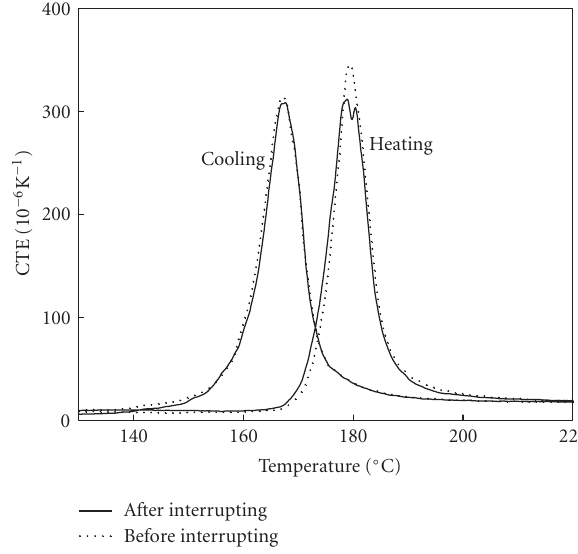
Figure 5: Temperature dependence of CTE for Ni 53 . 6 Mn 27 . 1 Ga 19 . 3 alloy after an incomplete cycle.